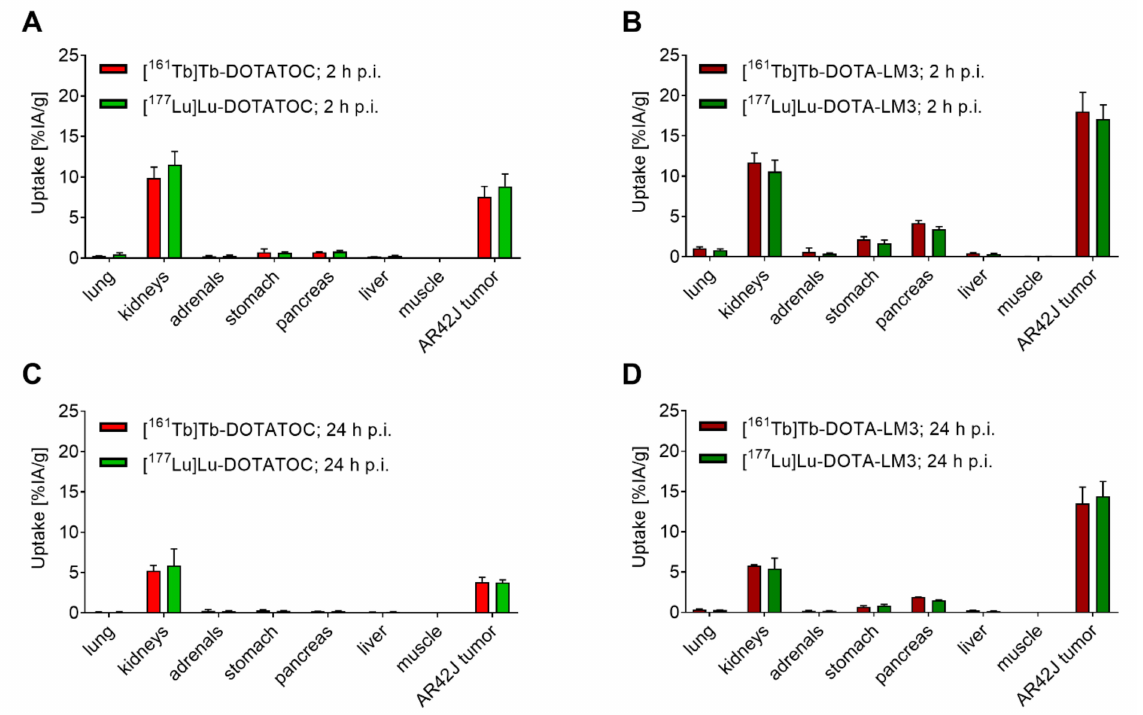
Figure 2. Biodistribution data obtained in AR42J tumor-bearing mice. ( A , B ) Tissue distribution at 2 h after injection of the radiopeptides; ( C , D ) Tissue distribution at 24 h after injection of the radiopeptides. The results are presented as percentage of injected activity per tissue mass (% IA/g). ( A , C ) Data obtained with [ 161 Tb]Tb-DOTATOC and [ 177 Lu]Lu-DOTATOC ( p > 0.05); ( B , D ) Data obtained with [ 161 Tb]Tb-DOTA-LM3 and [ 177 Lu]Lu-DOTA-LM3 ( p